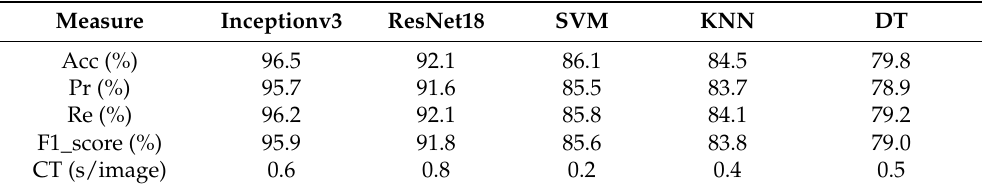
Table 8. Classification performance measures of all the applied